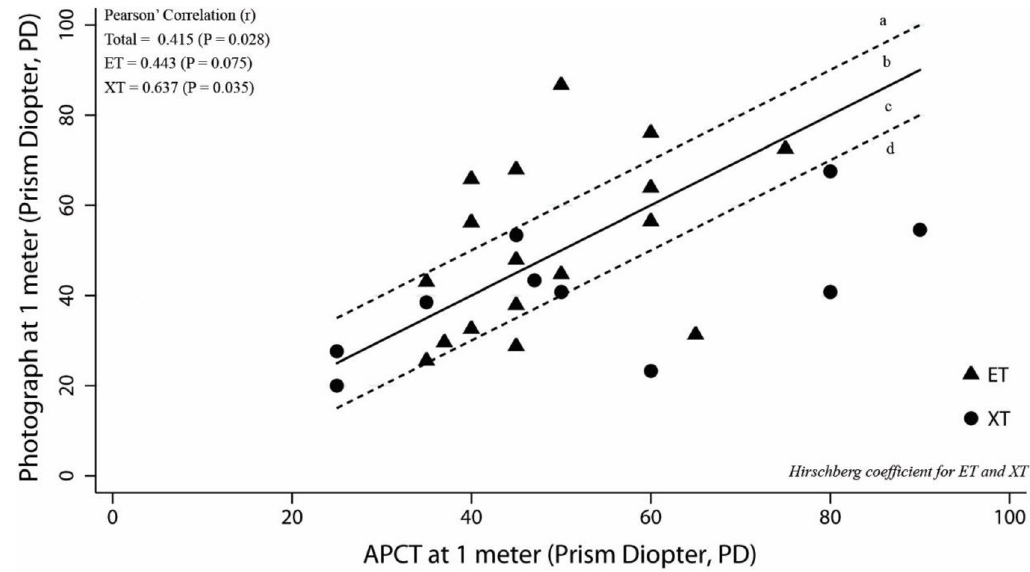
Fig 3. The relationship between angle of deviation from the Photo-Hirschberg test with APCT at N. The solid line is the line of equality and the zone between dotted lines represents range ± 10 PD of the APCT values. The acceptable area were b and c. The unacceptable area were a and d. (ET = esotropia;XT =